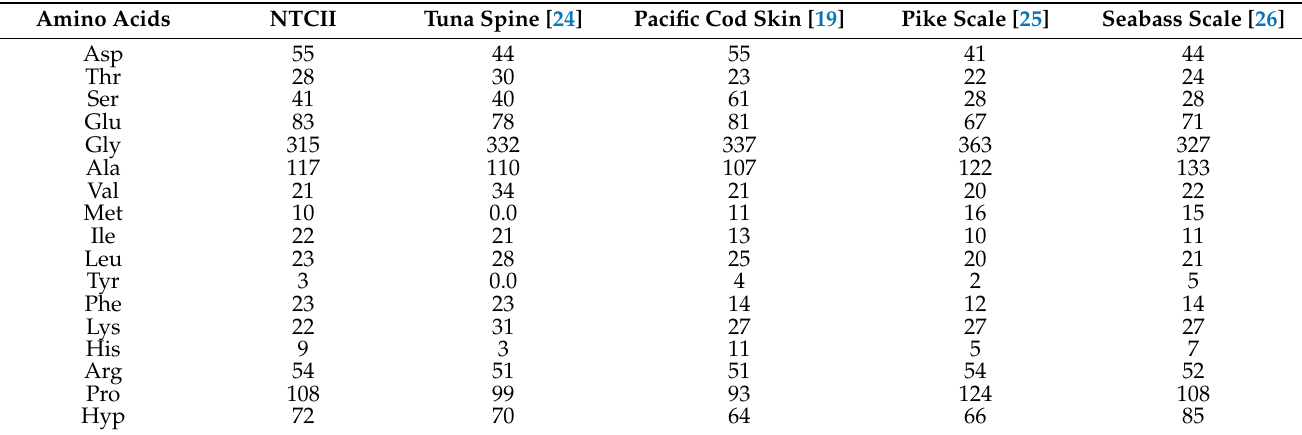
Table 3. Amino acid compositions of NTCII and other collagen samples (residues/1000